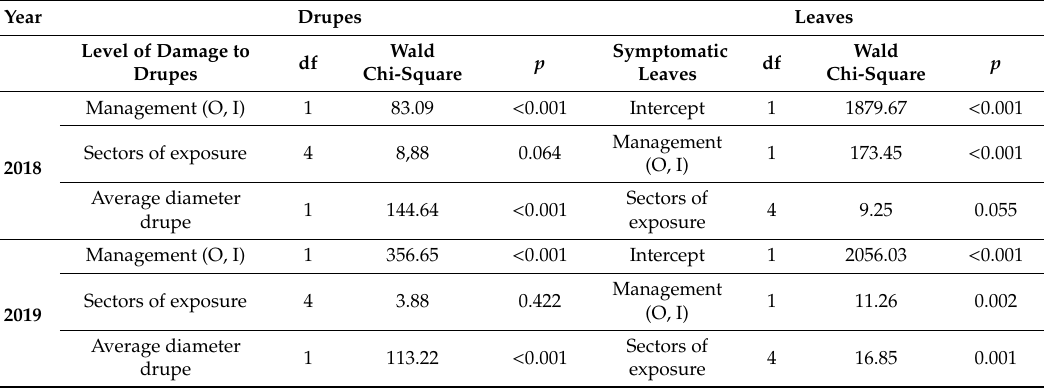
Table 3. Generalized linear model (GLM) evaluating the main e ff ects on the damage level of drupes (2018: n = 1600; 2019: n = 1600) and symptomatic leaves (Figure 1b,c). Organic management (O), integrated management